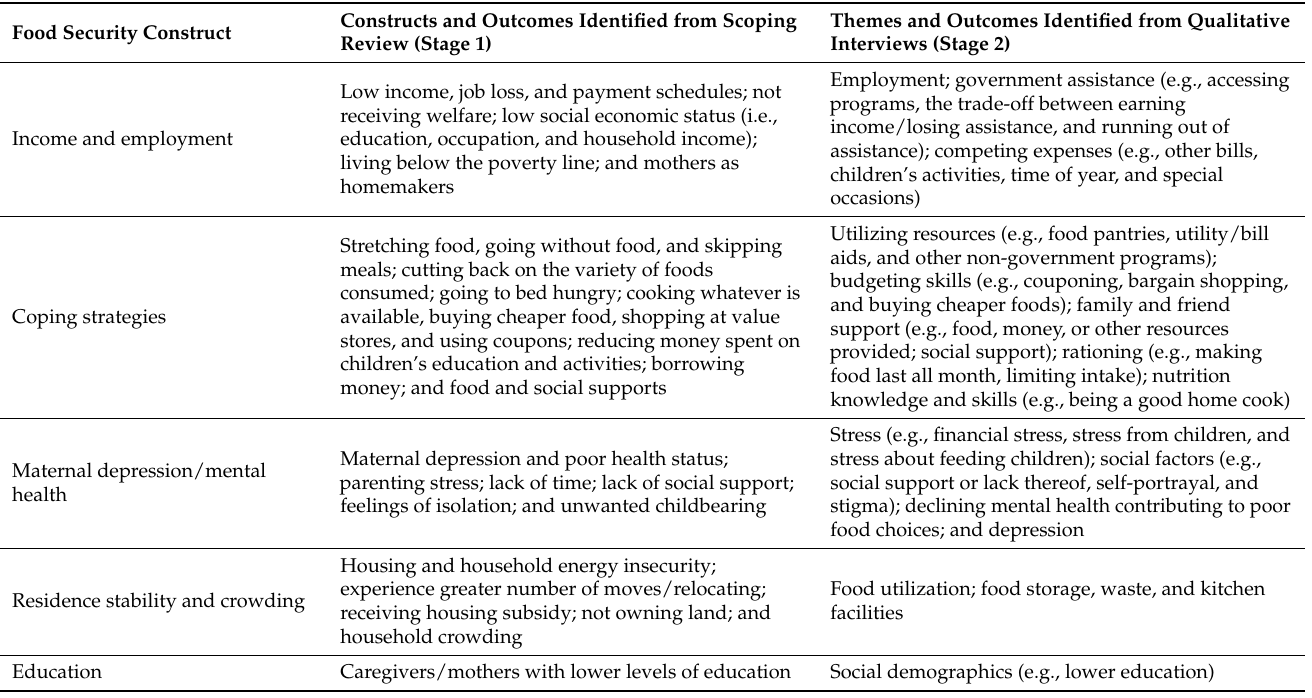
Table 1. Constructs and themes associated with food security in pregnant women or households with young children aged 0–6 years